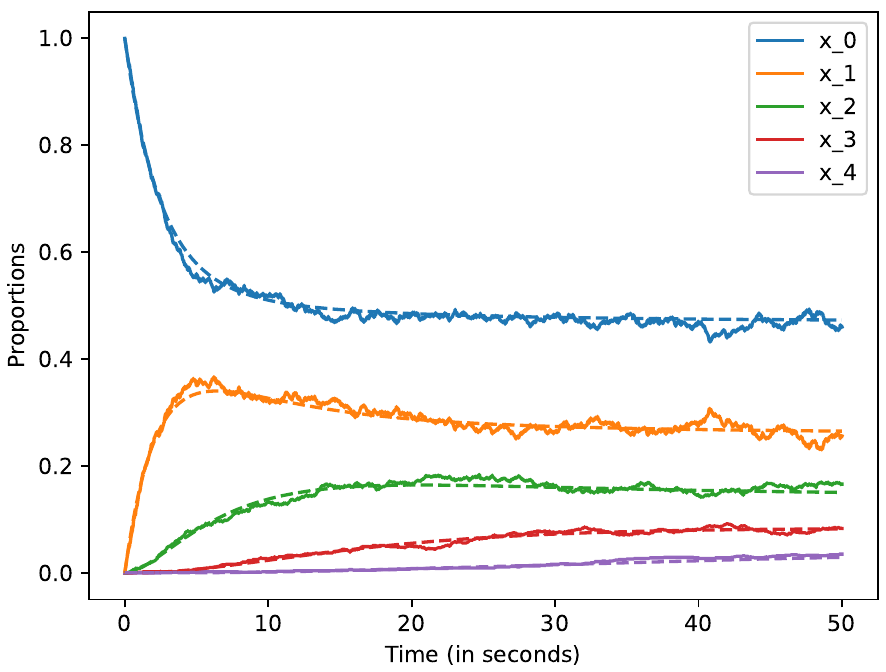
Figure 6. Mean-field approximation for N = 500 devices. Time in seconds.